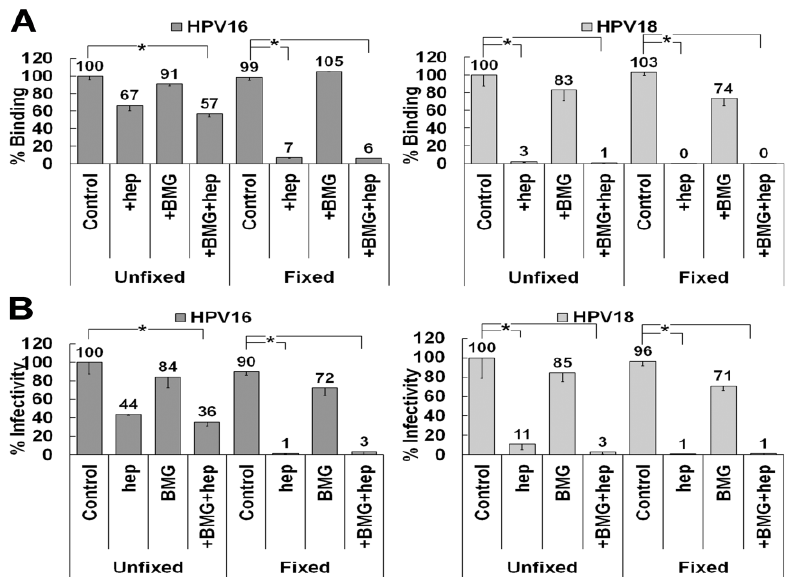
Figure 6. LN332 processing by matrix metalloproteinases (MMPs) does not affect ECM